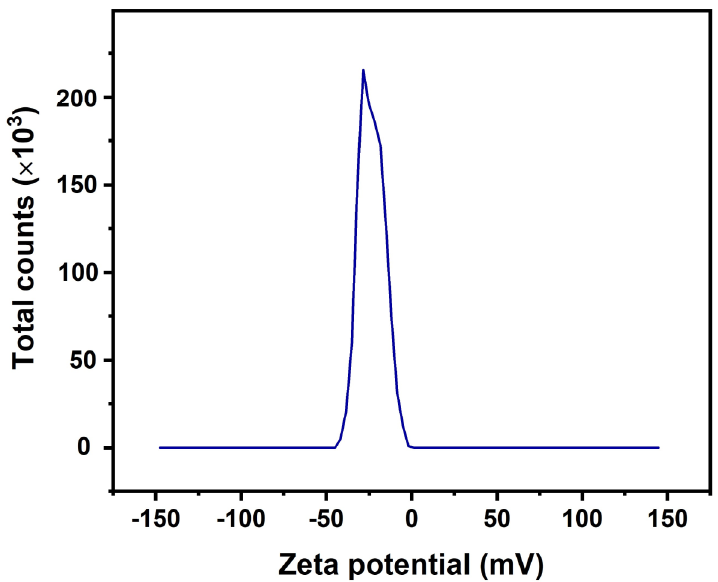
Figure 6. Zeta potential measurement of modified nano titania.